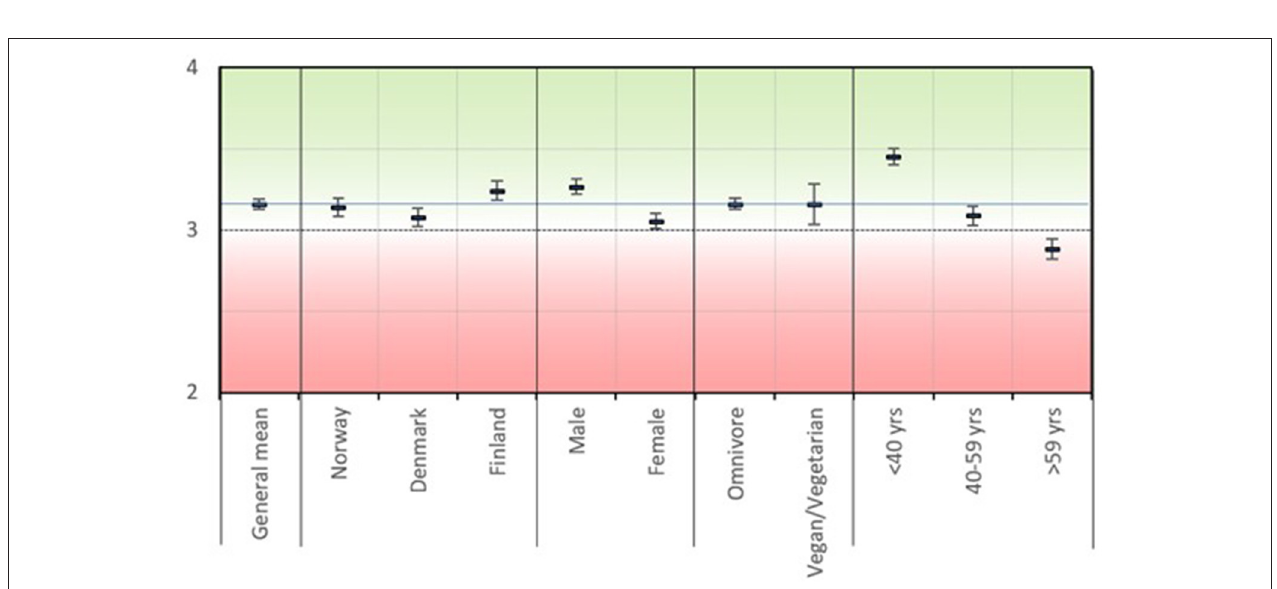
FIGURE 2 | Mean ratings of the intention to consume cultured protein. The thin blue line represents the general mean across all respondents. The error bars represent 95% credibility